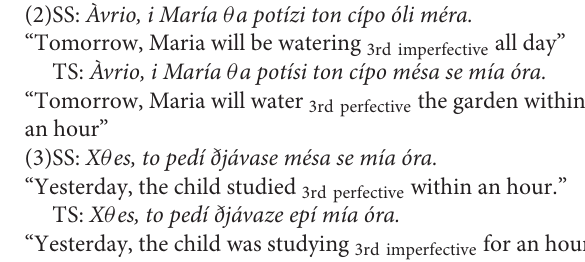
MCI vs. Control group